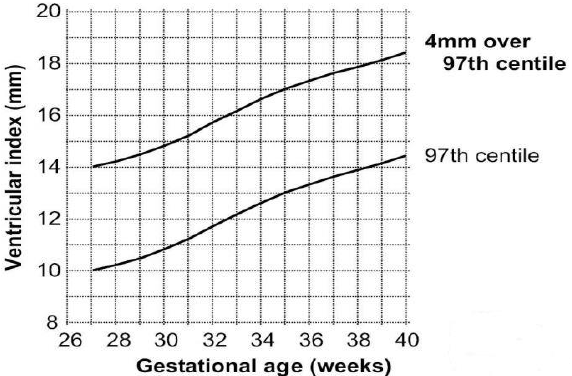
Figure 3. The 97th and 97th + 4 mm lines of VI at different gestational ages (source: Levene et al. [9] Arch Dis Child. 1981, 56: 900 – 904; VI: ventricular index). Arch Dis Child. 1981, 56: 900–904; VI: ventricular